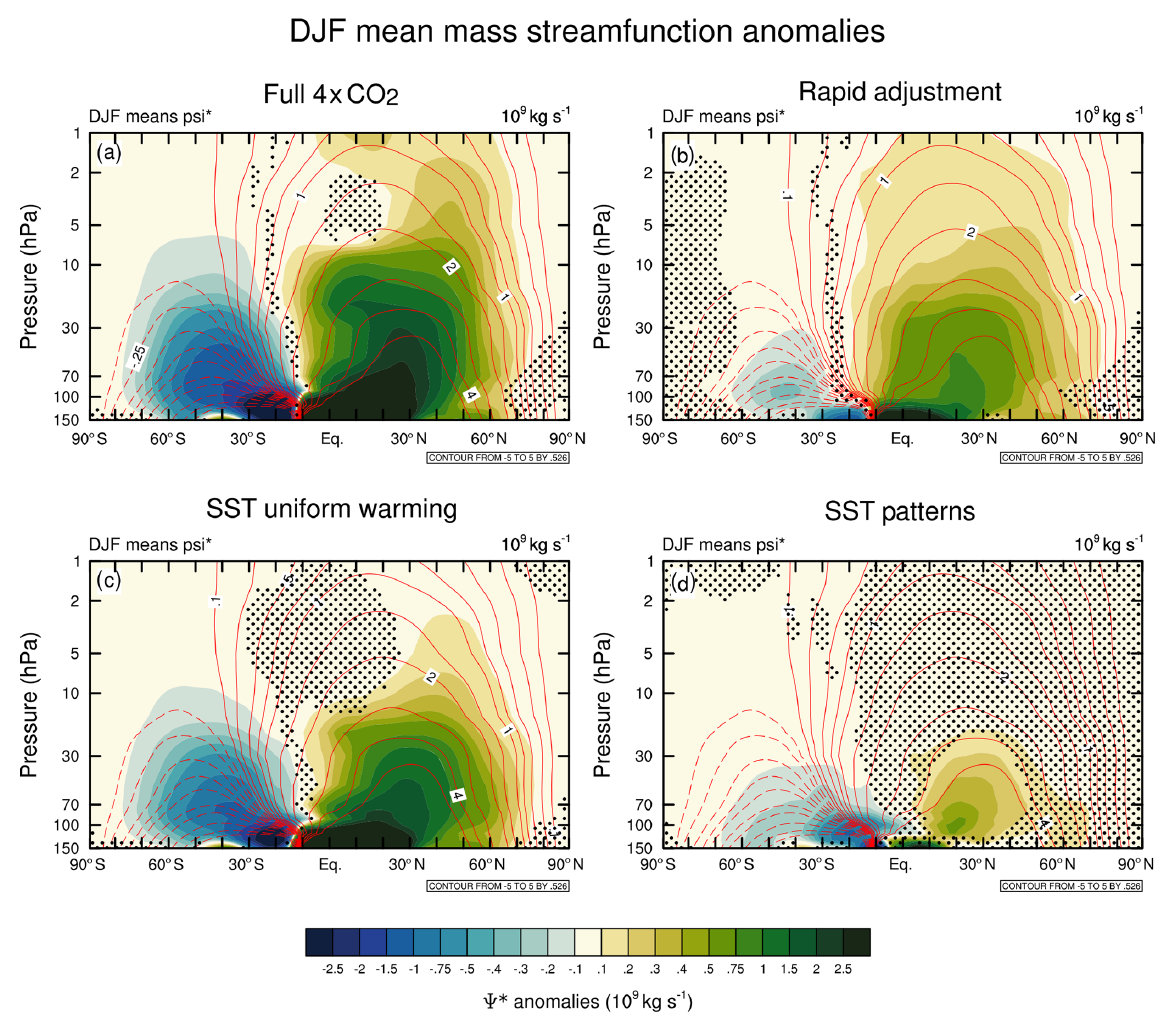
Figure 5. DJF mean residual mass streamfunction anomalies (10 9 kgs − 1 ) between 150 and 1hPa with respect to the piControl simulation for the (a) 4 × CO 2 (run B), (b) rapid adjustment (run C), (c) uniform SST warming (run D) and (d) SST pattern (run E) experiments. Stippling denotes where the differences are not statistically significant at the 95% confidence level using a two-tailed Student’s t test. Red contours plotted at − 5, − 4, − 3, − 2, − 1 . 5, − 1, − 0 . 75, − 0 . 5, − 0 . 25, − 0 . 1, 0.1, 0.25, 0.5, 0.75, 1, 1.5, 2, 3, 4, and 5 × 10 9 kgs − 1 show the piControl climatology with negative values shown in dashed